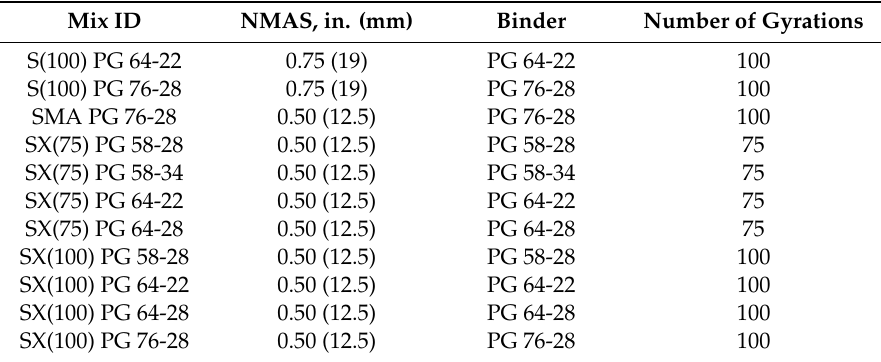
Table 1. Eleven mixtures used in this